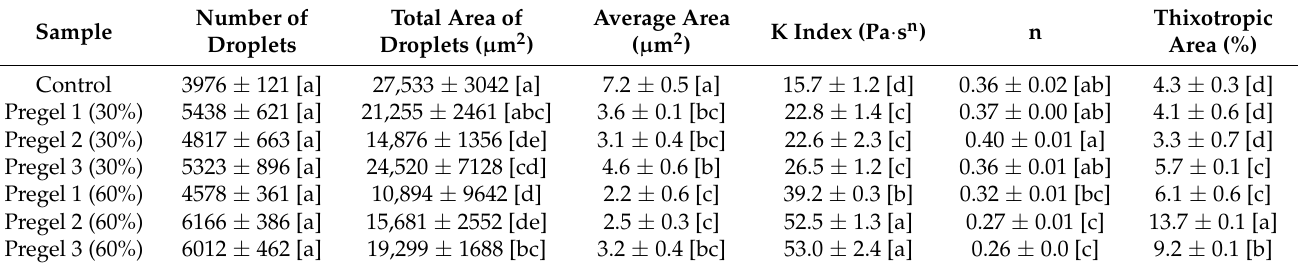
Table 2. Average area, total area of droplets, number of droplets and rheological parameters for full-fat and reduced-fat oil-in-water emulsions.